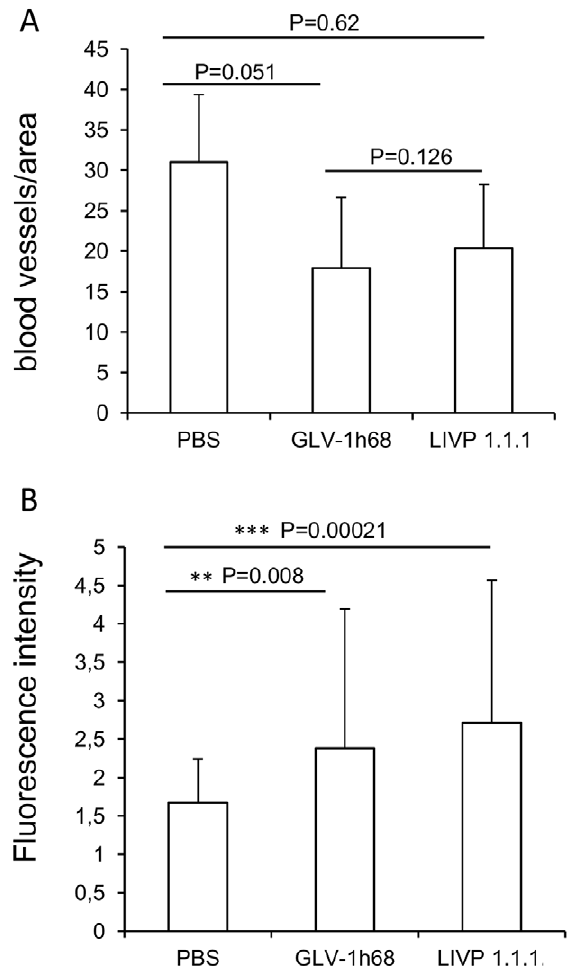
Figure 8. Determination of vascular density using CD31 immunohistochemistry in virus- treated and non-treated tumors at 7 dpvi. ( A ) Blood vessel density in STSA-1 tumors The vascular density was measured in CD31-labeled tumor cross-sections (n=3 mice per group) and presented as mean values + / 2 standard deviations. The study was repeated in an independent experiment. There were no significant differences between groups (P . 0.05, Student’s t-test). ( B ) Fluorescence intensity of the CD31 signal of blood vessels . The fluorescence intensity of the CD31-labelling represented the average brightness of all vessel-related pixels and determined as described by [32]. The fluorescence signal was measured in 18 images of each tumor (n=3 mice per group). Shown are the mean values + / 2 standard deviations. The study was repeated in an independent experiment. (*** P , 0.001, **P , 0.01, Student’s